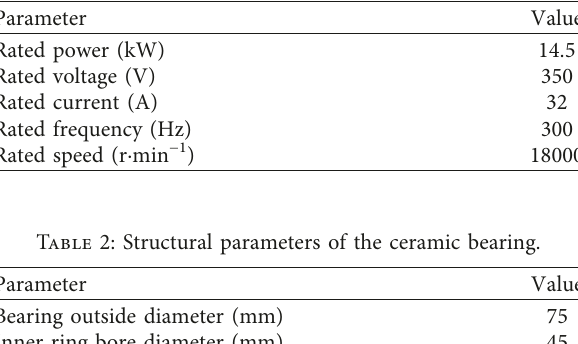
Table 1: Performance parameters of the motorised spindle.